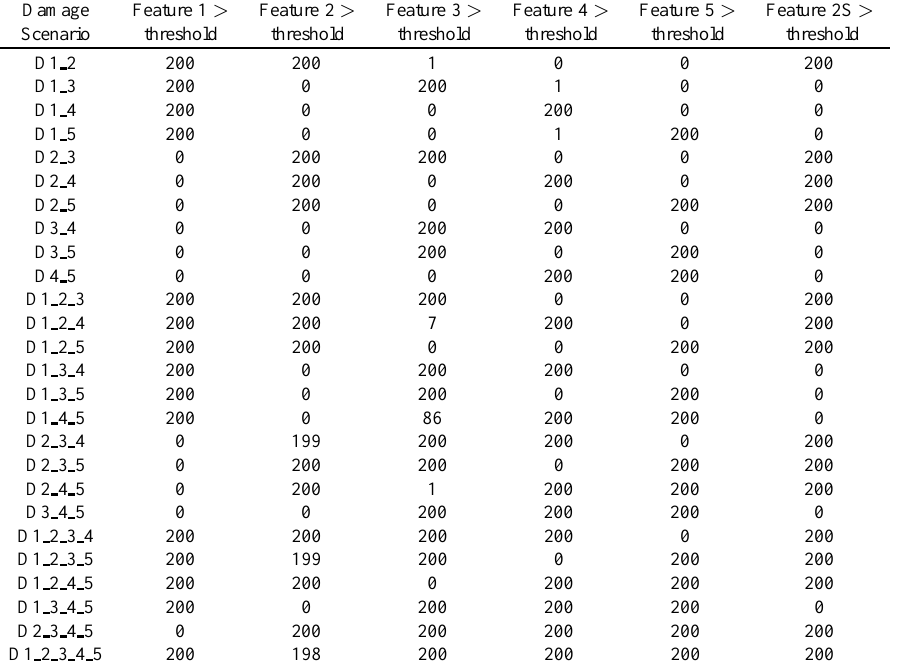
Table 2 Summary of univariate outlier results for advanced features when presented with multiple site